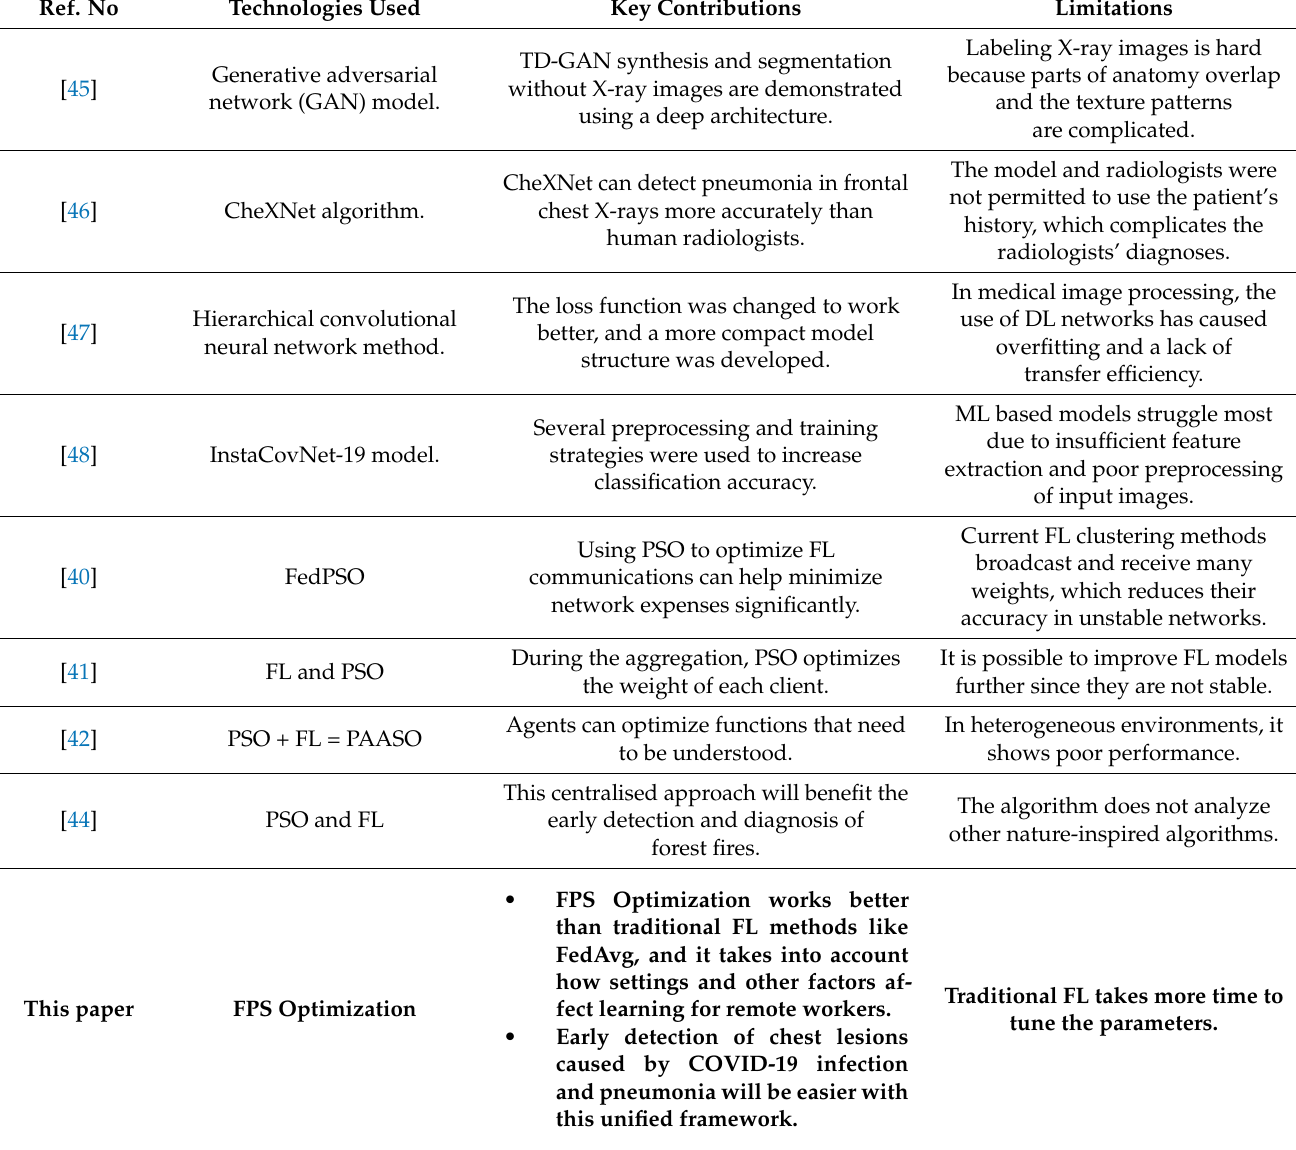
Table 1. Summary of Important Surveys on FL and PSO